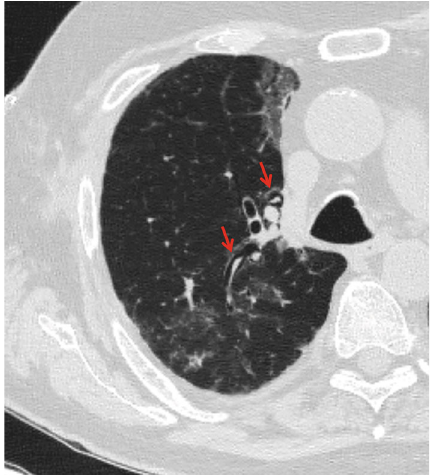
Figure 4: Initial axial chest CT two weeks prior shows interstitial emphysema along the bronchovascular bundle (red arrows).